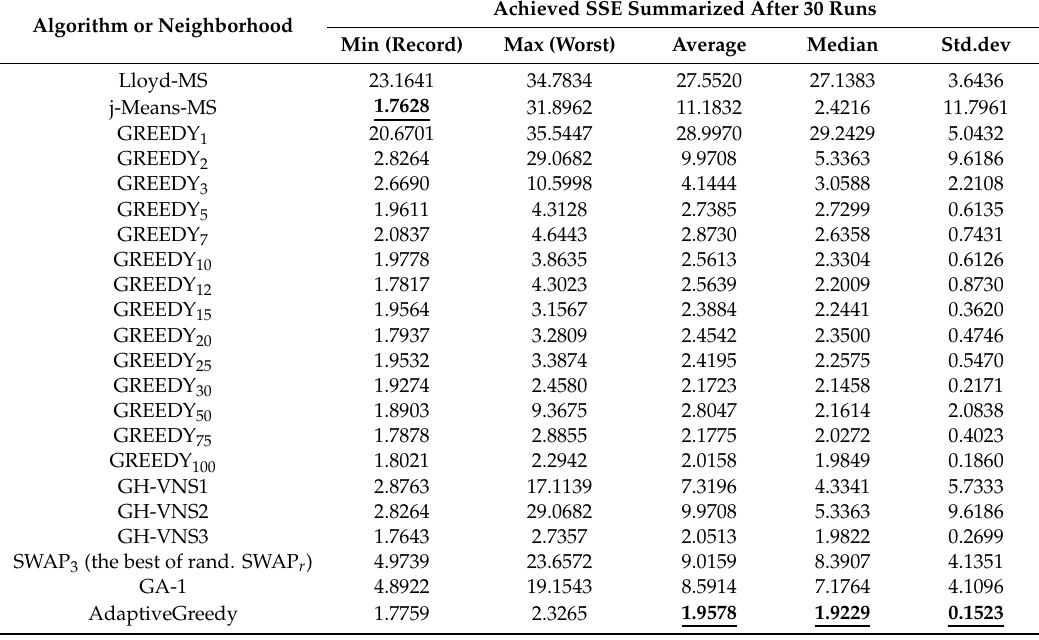
Table A2. Comparative results for Mopsi-Joensuu data set. 6014 data vectors in R 2 , k = 100 clusters, time limitation 5